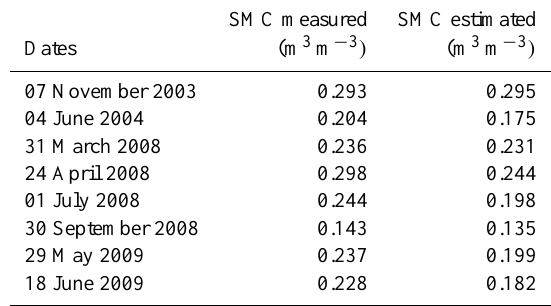
Fig. 6. Experimental (red) and simulated (blue) T b data (V pol.) of the whole dataset (Australia and Mongolia) as a function of SMC, in m 3 m − 3 (top: C-band; bottom: Ka band). Table 1. Comparison between measured and estimated averaged values of SMC (in m 3 m − 3 ) for the Scrivia test area at different